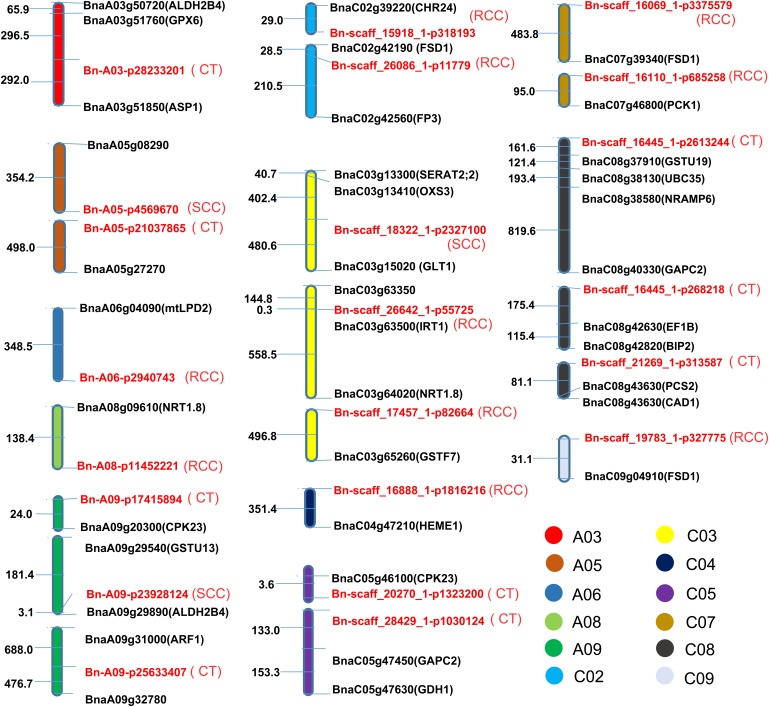
The distribution pattern of candidate genes and the corresponding SNPs associated with Cd accumulation. The abbreviations of orthologous genes in Arabidopsis thaliana are shown in brackets after the candidate genes. SNPs are marked in red. Numbers represent the relative distances in the genome, 1 = 1 kb.